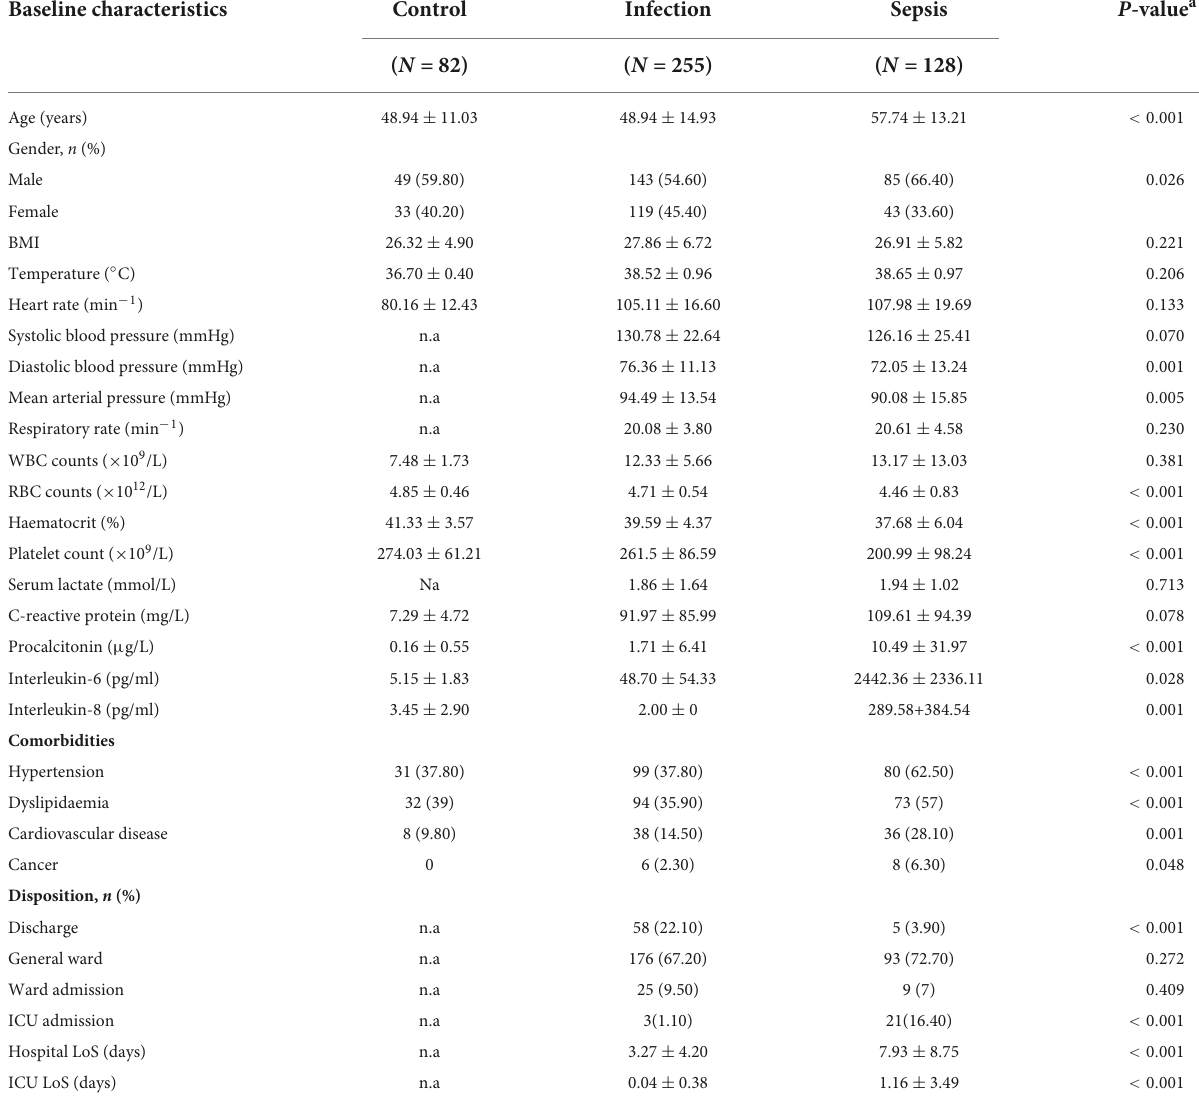
TABLE 1 Baseline characteristics of patients at emergency department (ED) admission. Baseline